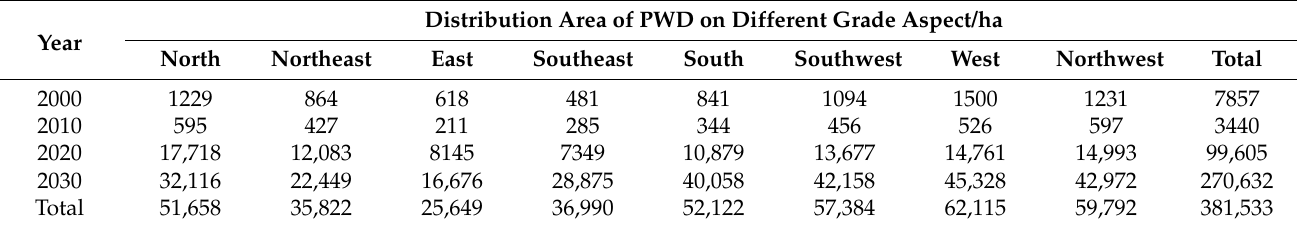
Table 5. Distribution area of PWD along aspect in each year in the study